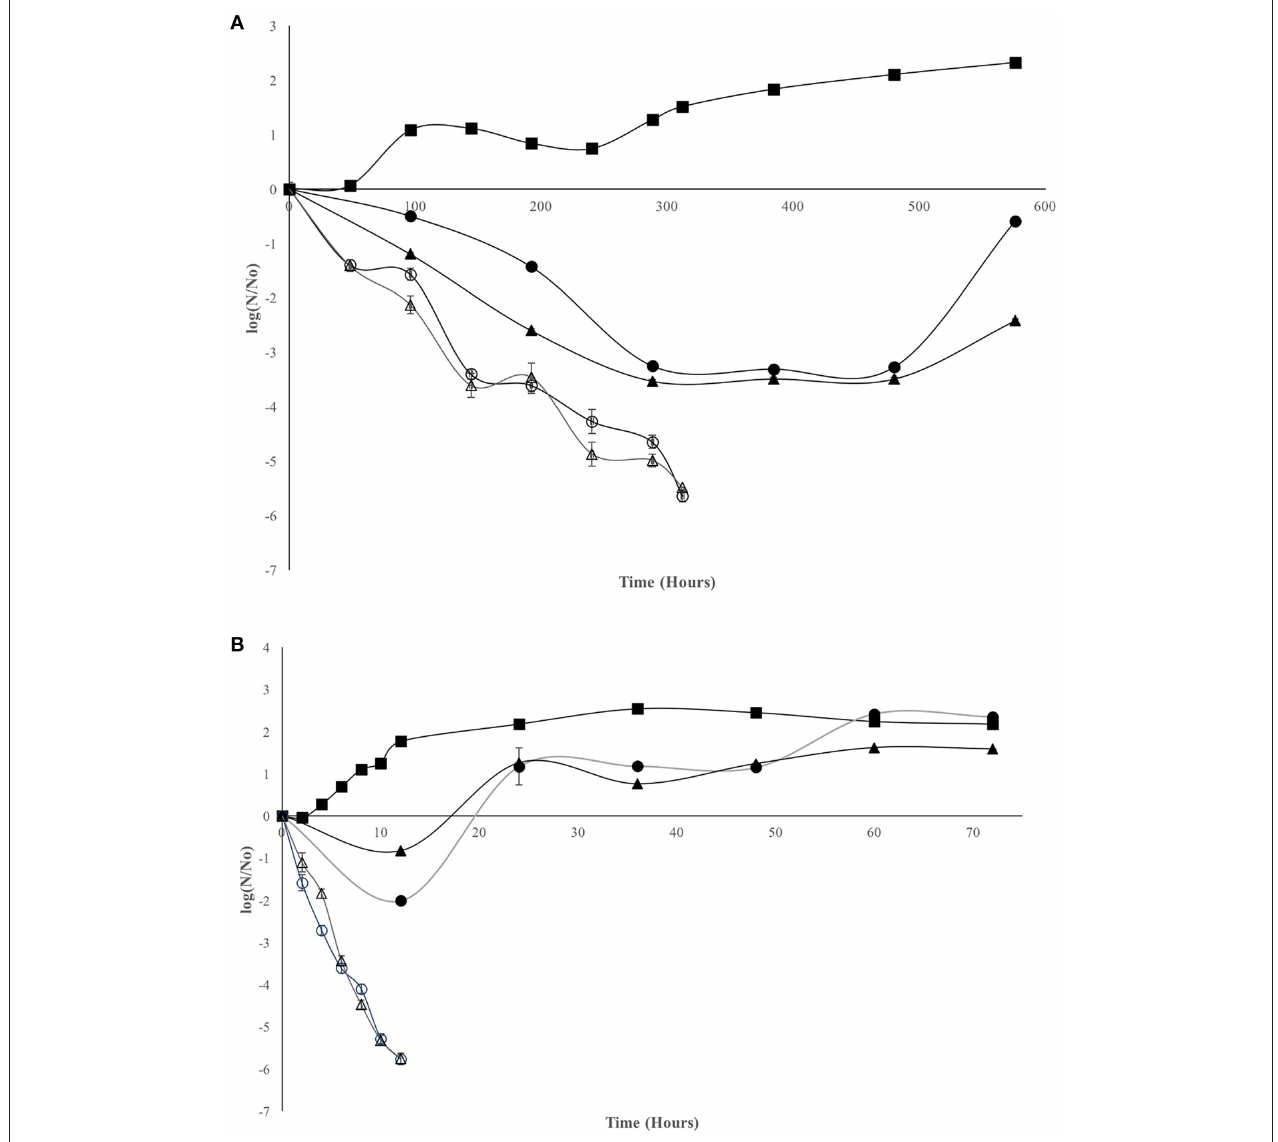
FIGURE 1 | Effect of chitosan on Vibrio cholerae Non-01 at selected concentrations and molecular weight [Control ( (cid:4) ), low molecular weight 600 ( • ) and 1,000 ( (cid:13) ); high molecular weight 600 ( N ), and 1,000 ( 1 ) mg/L], at different temperatures 5 ◦ C (A) and 35 ◦ C (B)